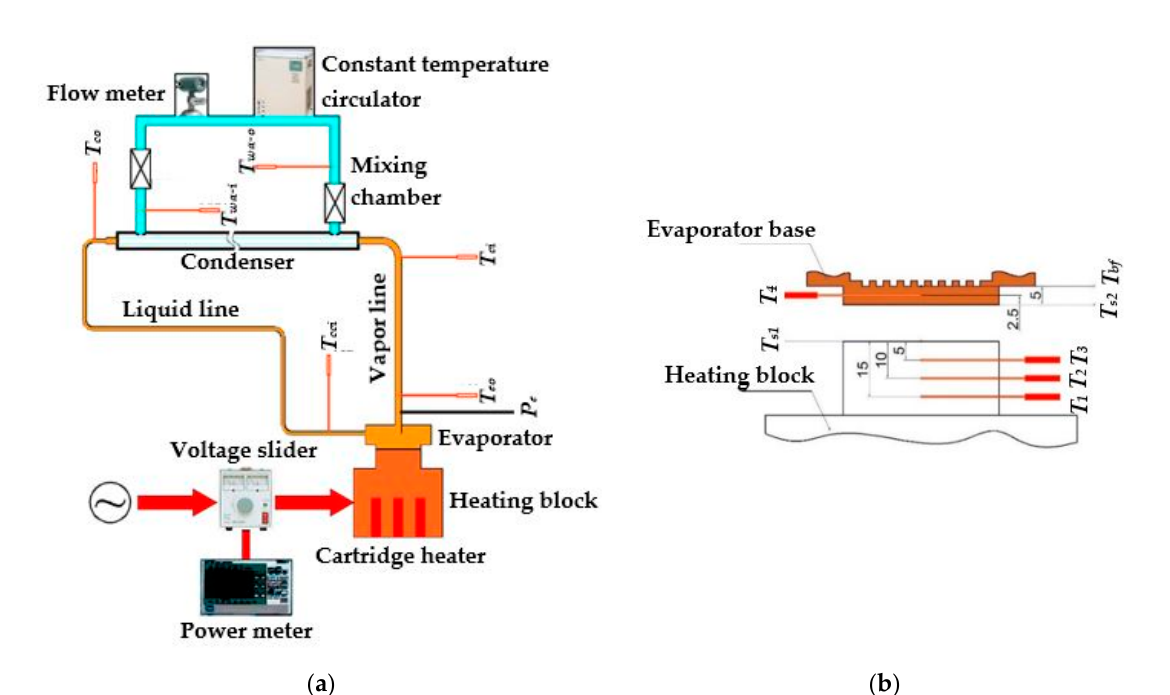
Figure 3. Test LHP: ( a ) Schematic diagram of the LHP and temperature measurement points. ( b ) The locations of thermocouples on heating block and evaporator.